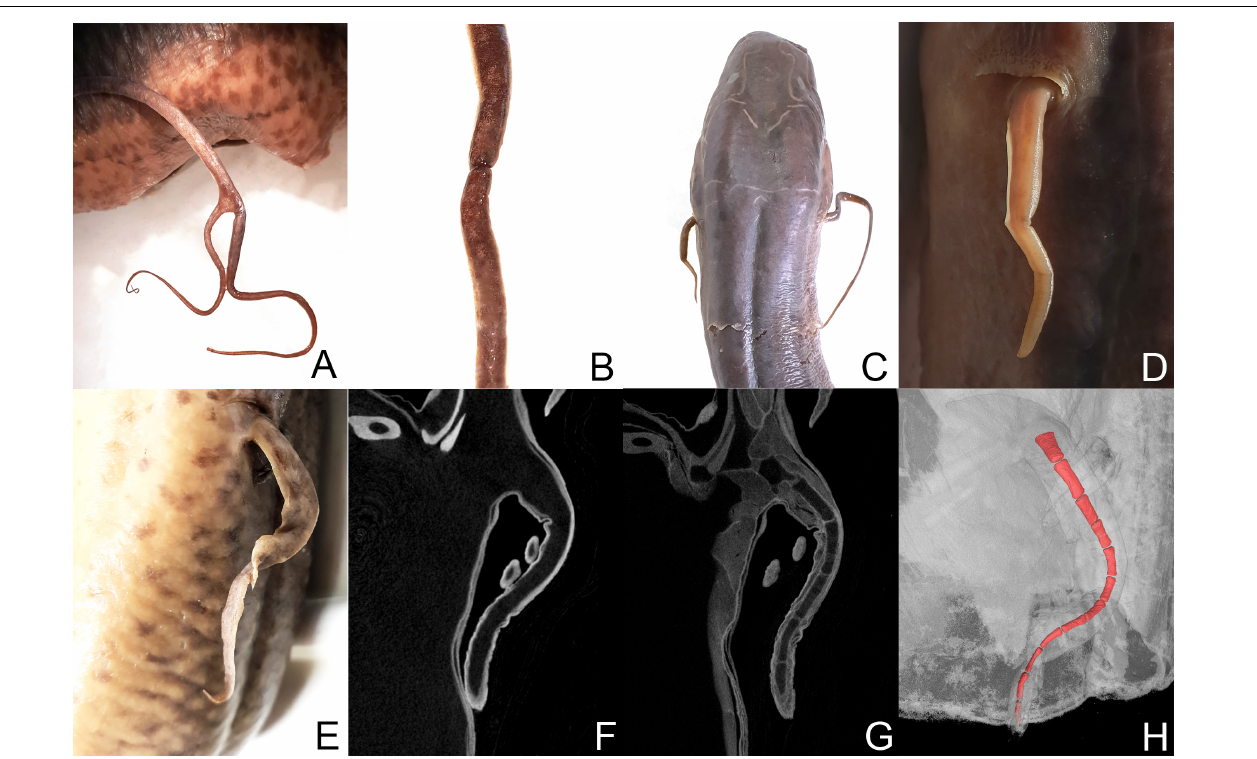
FIGURE 2 | Protopterus aethiopicus (RBINS 148): (A) bifurcation of the left pectoral fin and (B) constriction of the right pectoral fin. Protopterus dolloi (RBINS 8112): (C) paired pectoral fins. (D) Close-up of the shorten fin. Protopterus annectens brieni (RMCA_Vert_P.165214-165235): (E) left pectoral fin. (F) µ CT scan without tissue staining. (G) µ CT scan after staining with iodine. (H) 3D modeling of the